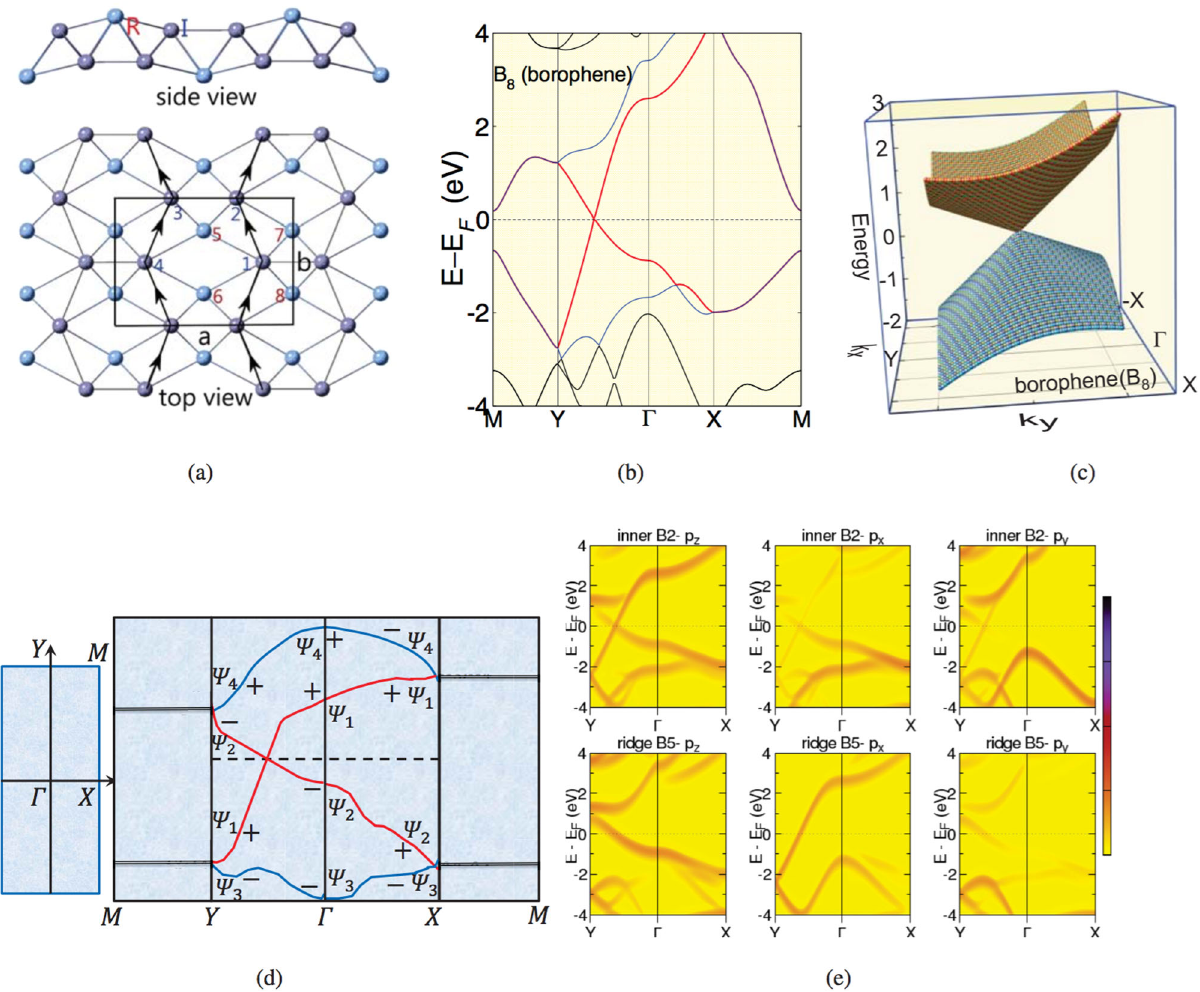
Fig. 1 Electronic structure of pure 8 Pmmn borophene. a Top and side view of crystal structure of 8 Pmmn borophene. The gray and faint teal circles denote inner (I) and ridge (R) boron atoms, respectively. b Density functional theory with Perdew-Burke-Ernzerhof parameterization (DFT-PBE) band structure of pristine 8 Pmmn borophene and ( c ) its three dimensional reconstruction. d First Brillouin zone and decomposition of elementary band representation the 8 Pmmn group. The ± are the eigenvalues of ~ C 2x , and ~ C 2y operations at high-symmetry points. e The orbital-projected band structures for two atoms of 8 Pmmn borophene based on DFT-PBE. The Fermi energy ( E F ) is set to the zero